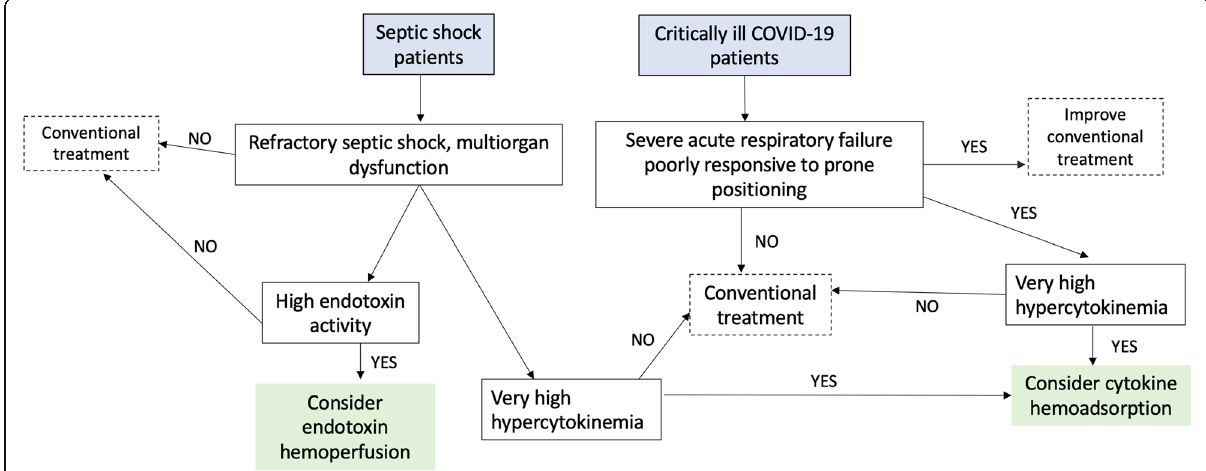
Fig. 1 Potential applications of cytokine and endotoxin hemoadsorption in sepsis and COVID-19. ECMO : extracorporeal membrane